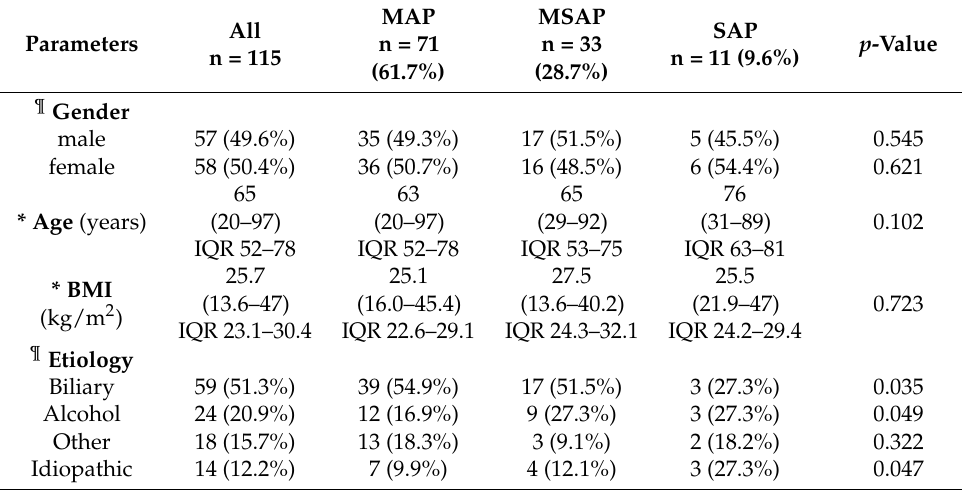
Table 1. Characteristics of